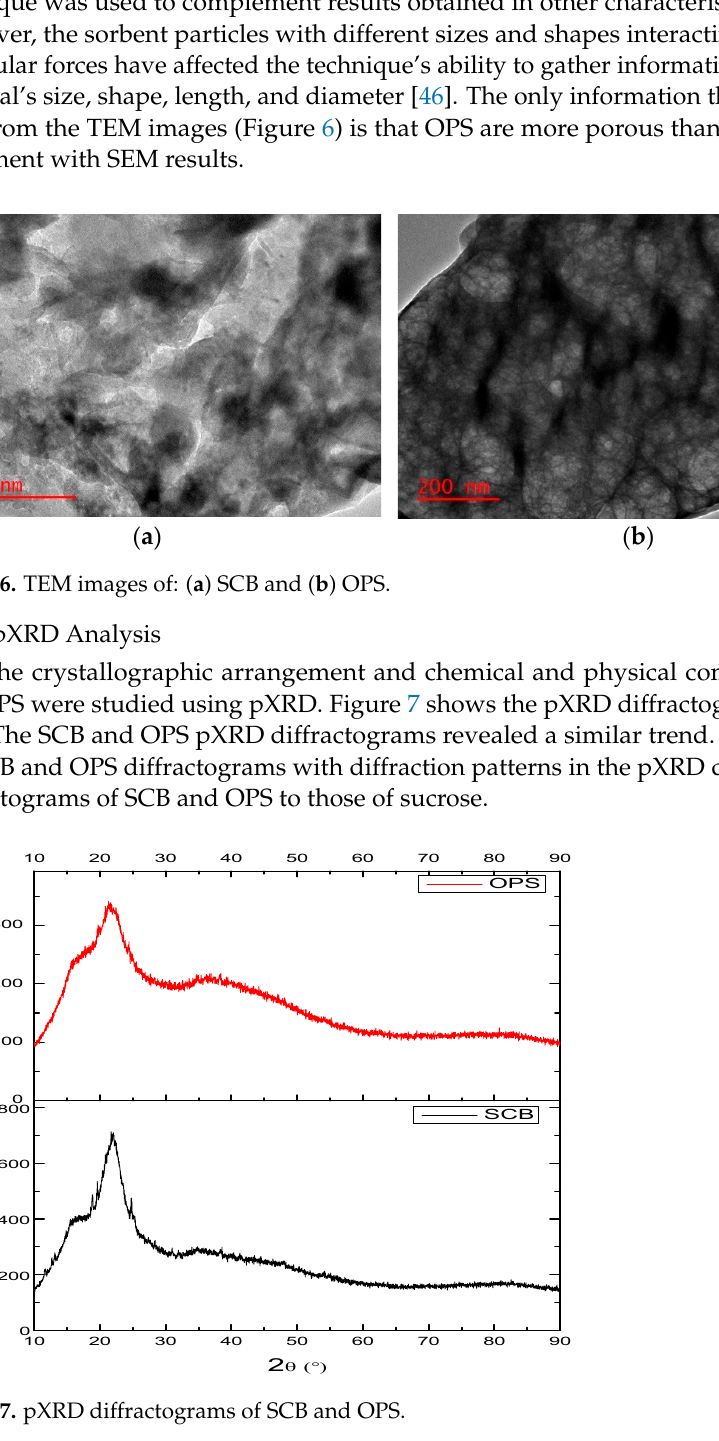
Figure 7. pXRD diffractograms of SCB and OPS.